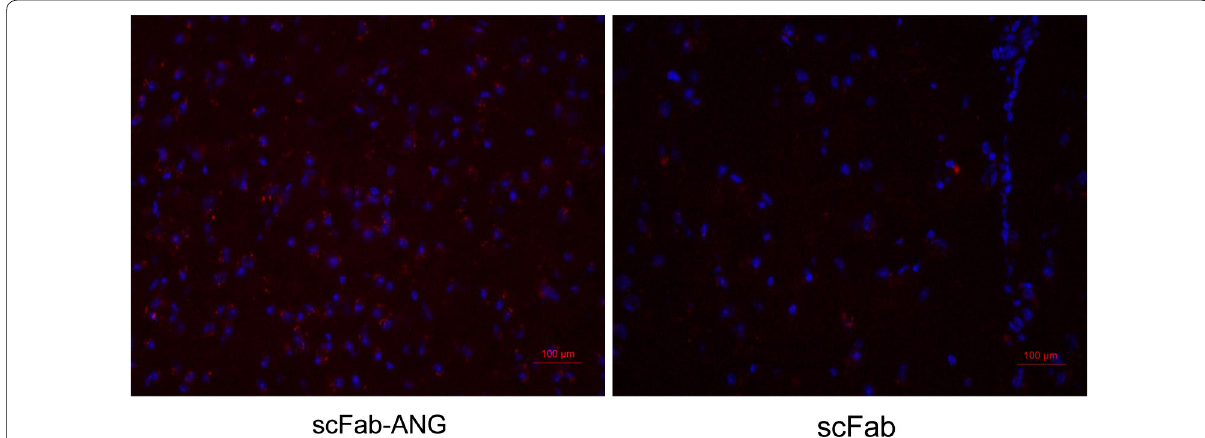
Fig. 4 Evaluation of penetration in vivo BBB. Fluorescent images of brain tissue slices in different groups. Blue represents cell nucleus stained by DAPI, red represents Cy3-labeled scFab-ANG (left) and Cy3-labeled scFab